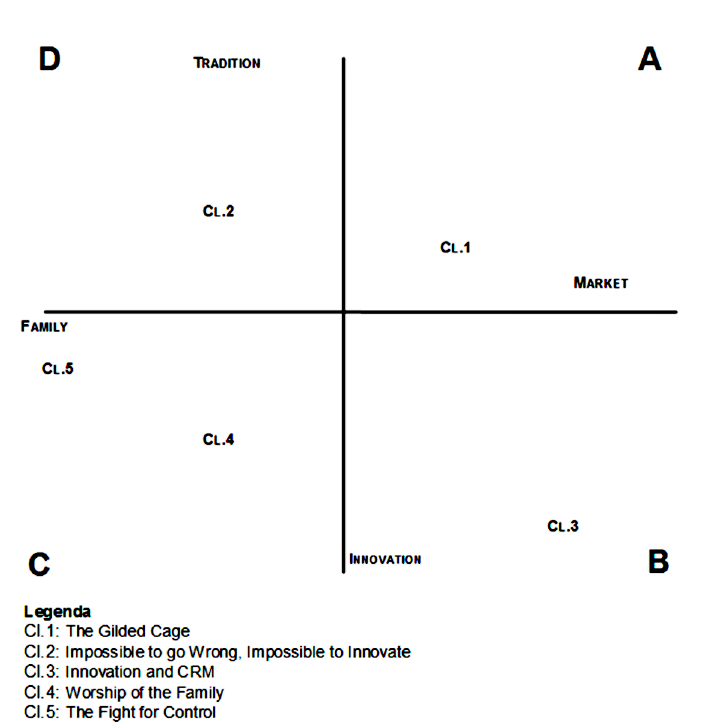
Figure 3. Representation of the X-Z